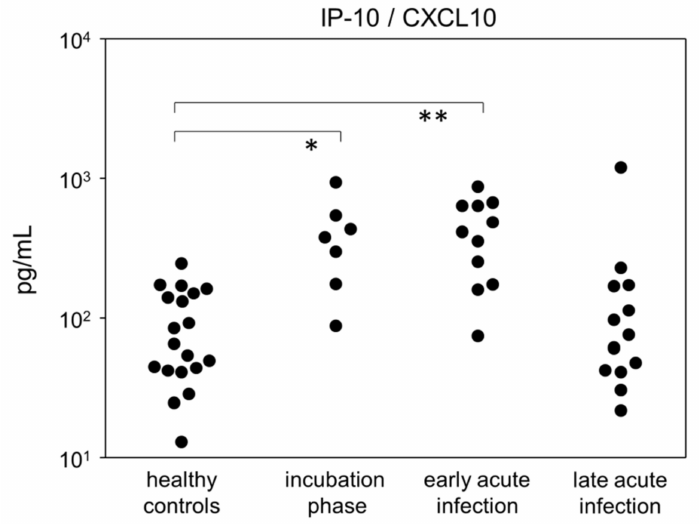
Figure 6. Quantitative data of IP-10 concentrations in plasma samples at different disease stages. * p < 0.05; ** p < 0.01; Tukey-Kramer